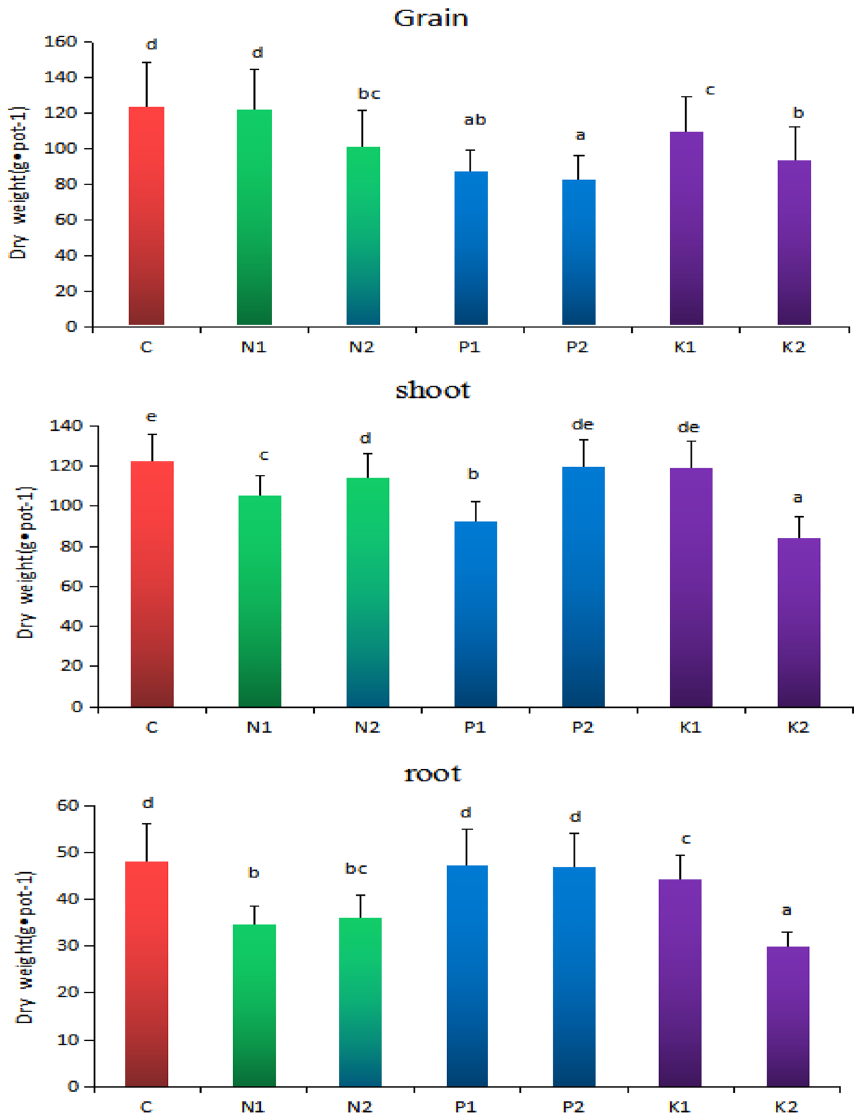
Figure 2. Effects of different rice straw returning methods on dry weight of rice roots, shoots and grains. Different letters indicate significant differences between potted rice in different